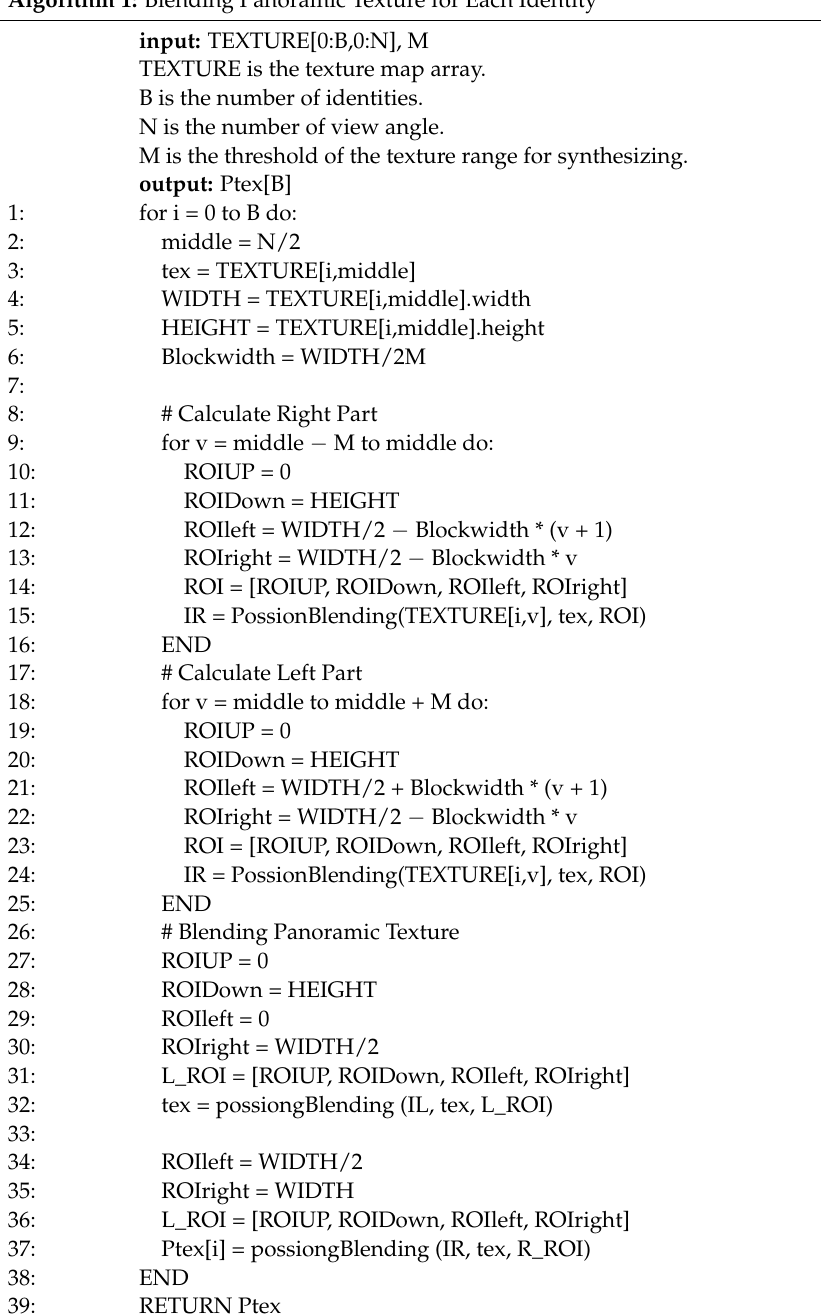
Algorithm 1: Blending Panoramic Texture for Each